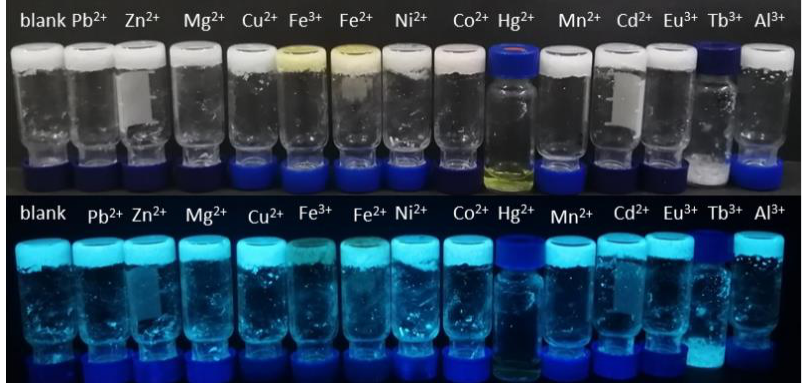
Figure 8. The images of gels of 1 with different metal ions.